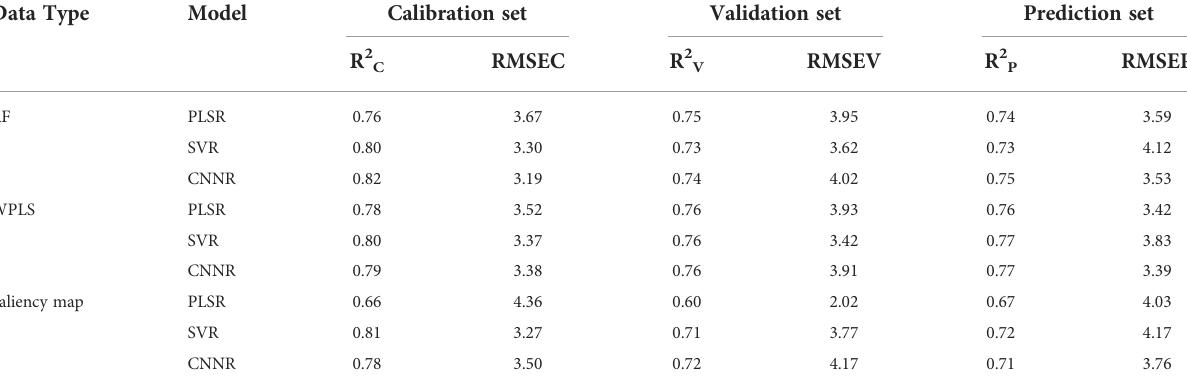
TABLE 6 The results of the regression models based on optimal wavelengths.